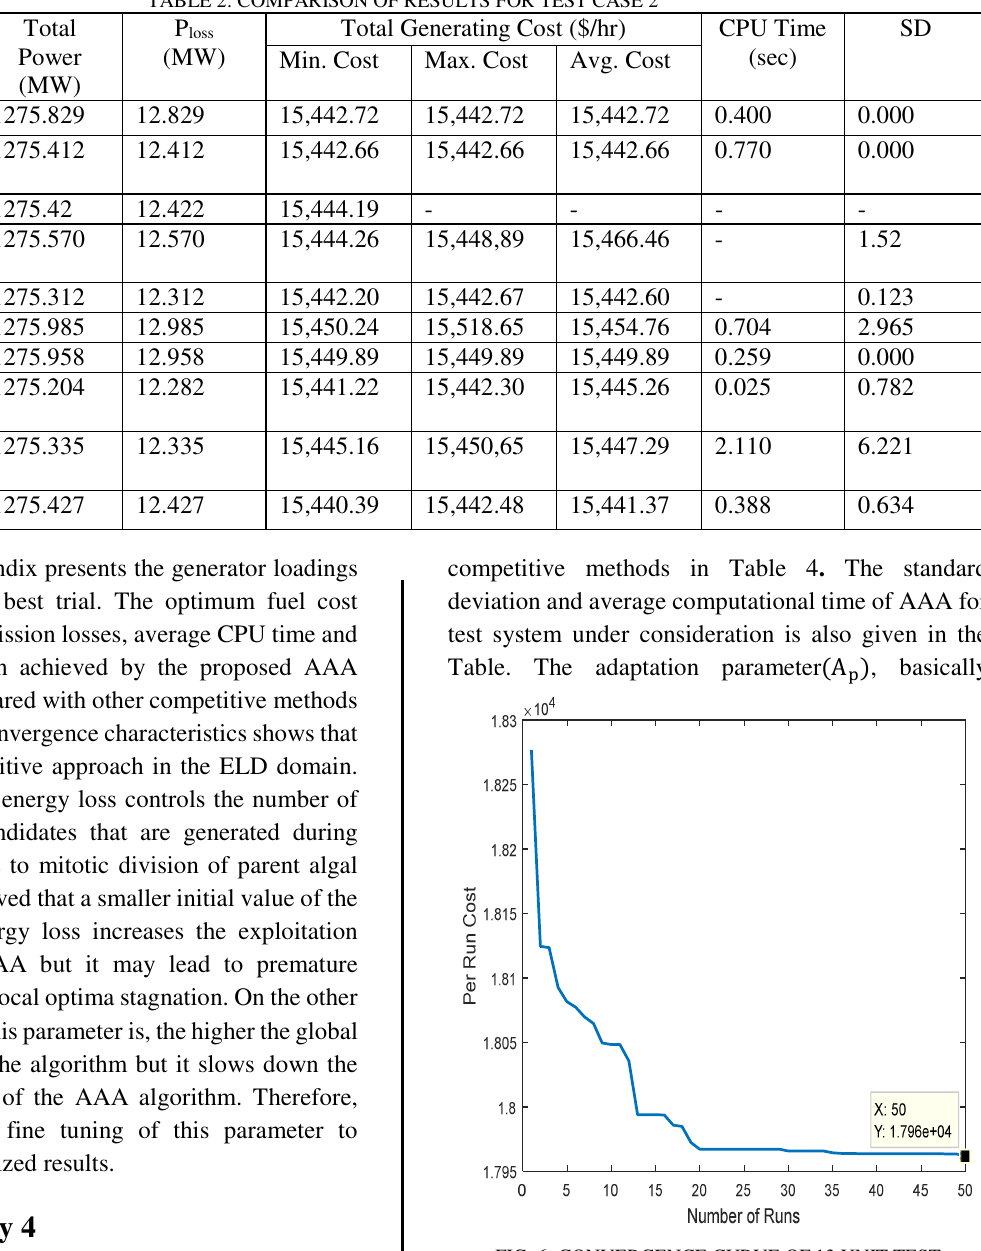
FIG. 6: CONVERGENCE CURVE OF 13 UNIT TEST